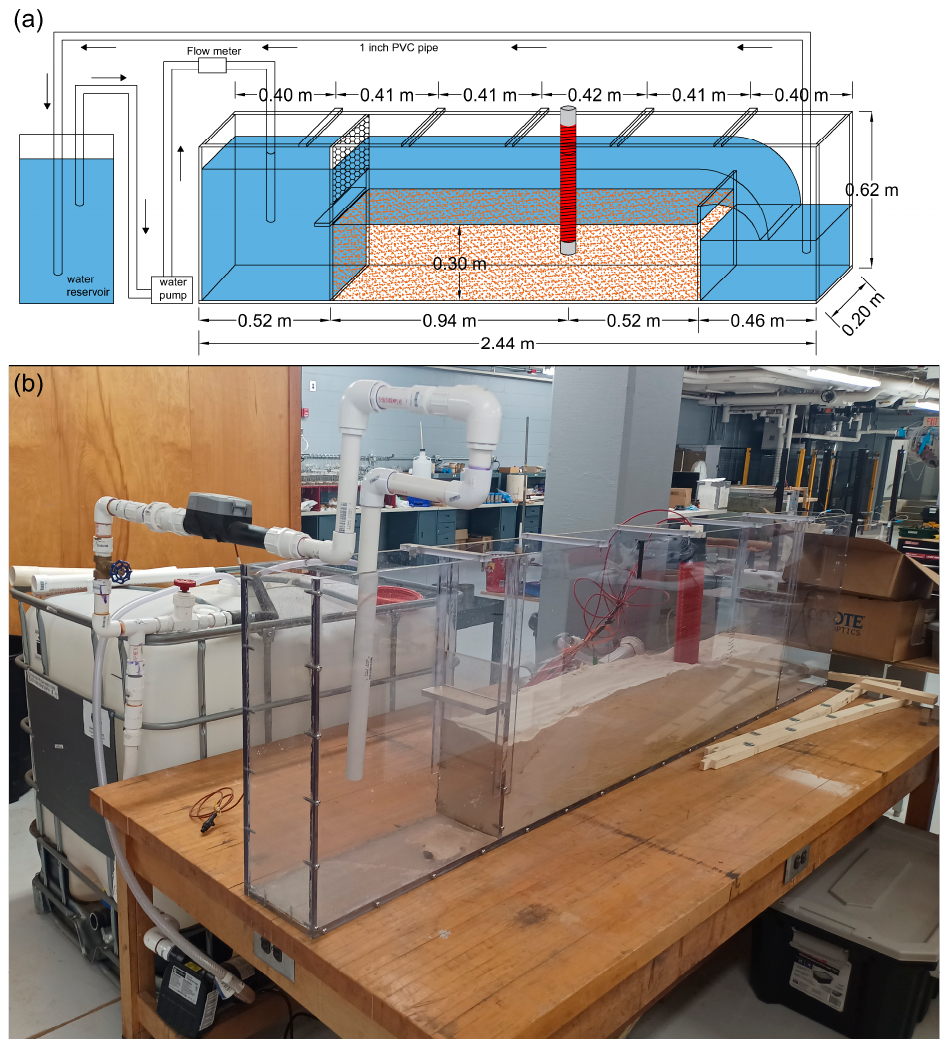
Figure 2. The used flume setup: ( a ) a schematic diagram of the flume setup showing its dimensions in meters and ( b ) the actual setup used to test the performance of the FO-DTS scour-monitoring device.